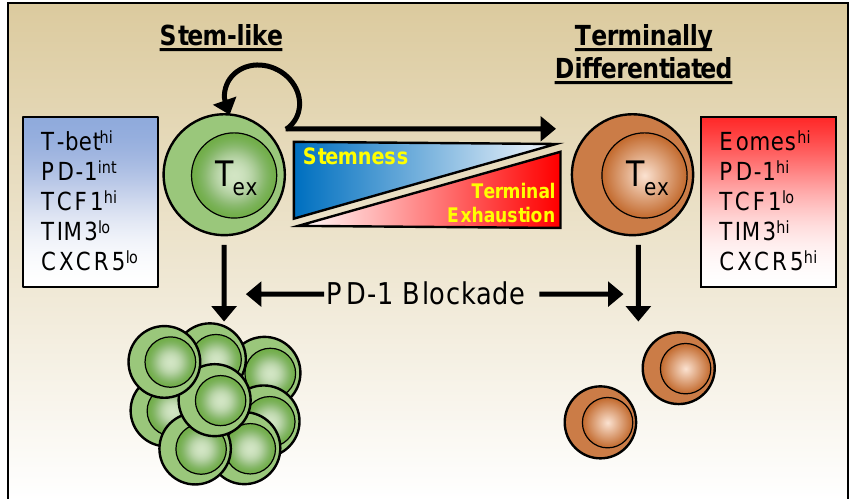
Figure 2. The exhausted CD8 T cell pool is heterogeneous, containing both populations of terminally exhausted cells (right) that are refractory to checkpoint blockade therapy, as well as populations of more “stem-like” cells (left) that can seed the terminally differentiated pool as well as persist and self-renew. This less terminally differentiated stem-like population is more capable of expansion following checkpoint